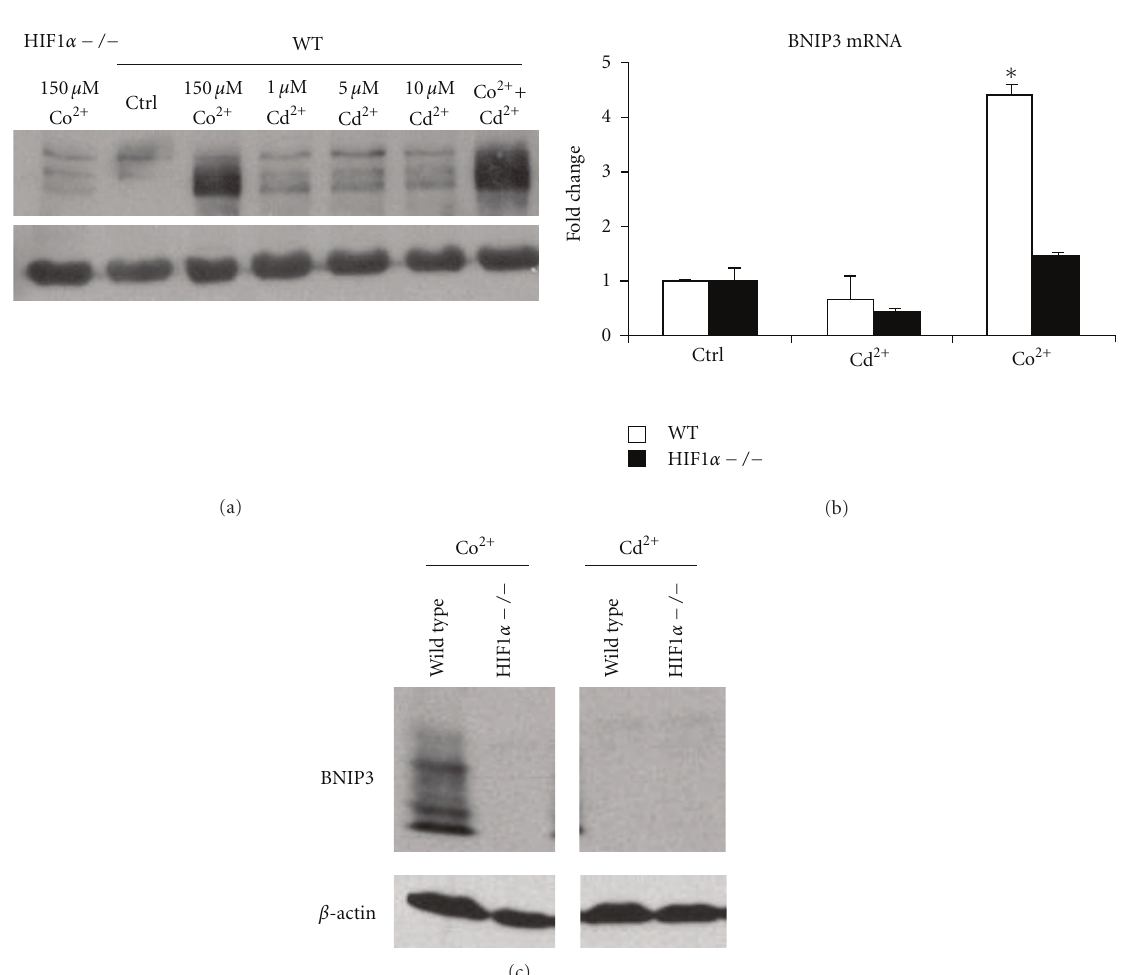
to a large increase in metallothionein protein in WT